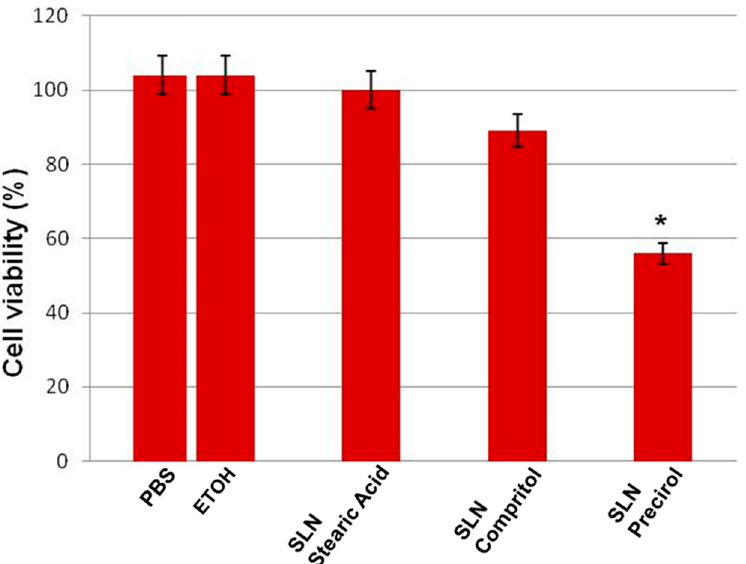
Figure 2. Percentage viability of primary human NSCs exposed to 0.005% of PBS (phosphate buffer saline solution), 0.005% ETOH (ethanol), stearic acid (3.5 µ M), Compritol 888 ATO (4.5 µ M), and Precirol 5 ATO (16 µ M) for 24 h. Results are expressed as the mean ± S.D. of the values of five independent experiments performed in triplicate. * p < 0.05 vs. controls (PBS and ETOH). SLN: solid lipid nanoparticles; NSCs: neuronal stem cells.